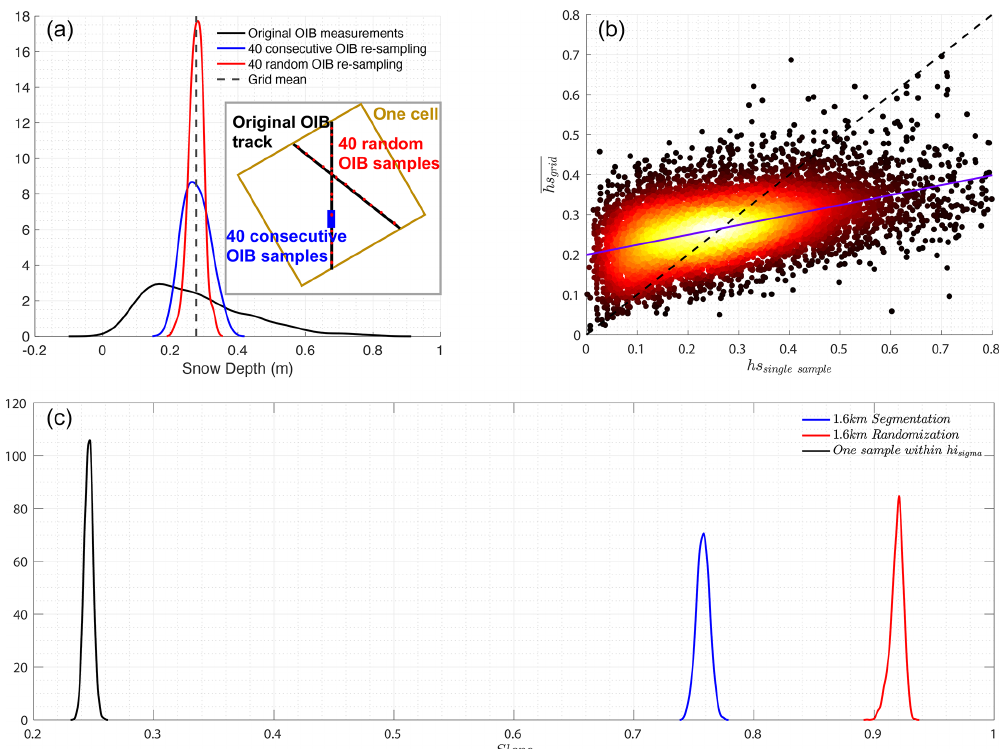
Figure 14. The study with OIB on the effects of sampling strategy for observations. Snow distribution within typical region (a) under different sampling method embedded with schematic on different strategies deployment: original OIB measurements (black), 40 consecutive OIB re- sampling (strategy II: blue) and 40 random OIB re-sampling (strategy I: red). Mean snow depth is shown by dashed lines. Typical fitting (b) between cell mean and a single sample snow depth for all regions, with fitting line in purple. Overall distribution of slopes (c) in three re-sampling strategies, fitting between OIB cell mean and 40 random OIB samples (strategy I), between OIB cell mean and 40 consecutive samples (strategy II), and between OIB cell mean and single sample within 1 σ of the mode of the ice thickness (strategy III: